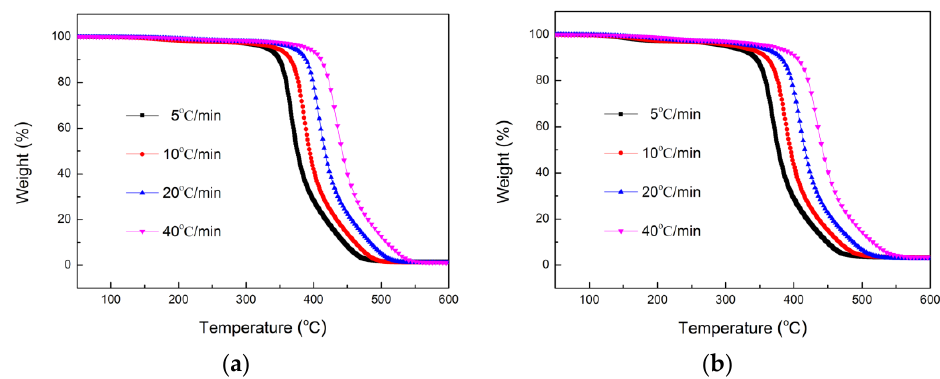
Figure 4. TGA curves of TE ( a ) and FRTE ( b ) composites.